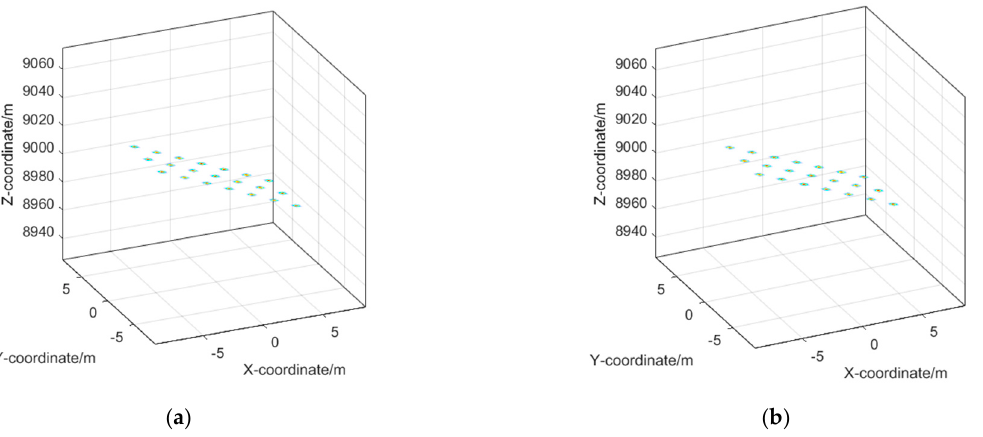
Figure 21. Imaging results of a set of scattering points with two sparse imaging algorithms. ( a ) Imaging result of Basis Pursuit algorithm; ( b ) Imaging result of OMP algorithm.